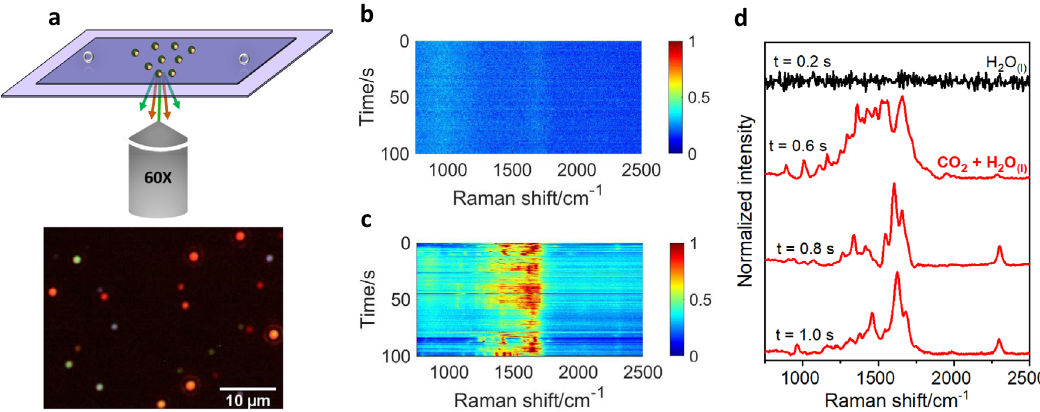
Fig. 1 In situ SERS probing of plasmon-excitation-driven CO 2 RR in an aqueous medium. a Top panel shows a schematic of the single-NP-level SERS spectroscopy set-up used for probing CO 2 photochemistry on a Ag NP in water, i.e., H 2 O (1) . The Ag NP was immobilized inside a micro fl uidic cell placed in an inverted optical microscope and subject to continuous-wave focused laser excitation. Raman scattering was continuously collected using a ×60 objective. The bottom panel shows a representative dark- fi eld scattering image of the substrate coated with spatially resolvable Ag NP emitters. Representative spectrograms showing time series of in situ SERS spectra acquired from an individual Ag NP scatterer in b CO 2 -untreated H 2 O (1) and c CO 2 -saturated H 2 O (1) . The SERS intensity is coded by the color, as indicated by the legend. d Spectral slice, corresponding to t = 0.2 s, from the plot in b shows the lack of any vibrational modes. Spectral slices, corresponding to t = 0.6, 0.8, and 1.0 s from the plot in c show the spectral dynamics taking place in the presence of CO 2 -saturated H 2 O (1) under LSPR excitation. The spectra were normalized to a [0, 1] range prior to plotting in the form of spectrograms in b , c . The spectra were baseline-subtracted and normalized to a [0, 1] range prior to plotting in a vertically stacked manner in d . The baseline was determined by polynomial fi tting. Source data are provided as a source data fi